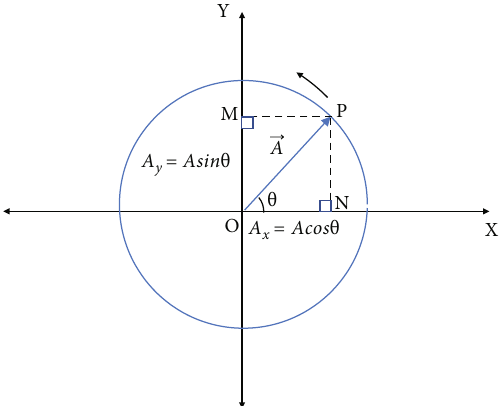
Figure 2: Phasor diagram depicting the components of a phasor (cid:5) ! OP = A ! along both coordinate axes. θ is the angle between OP and the positive x -axis direction. The points M and N are the projections of P onto the ordinate and abscissa, respectively. Projections M and N oscillate sinusoidally along their respective axes, while P executes uniform circular motion about the origin O